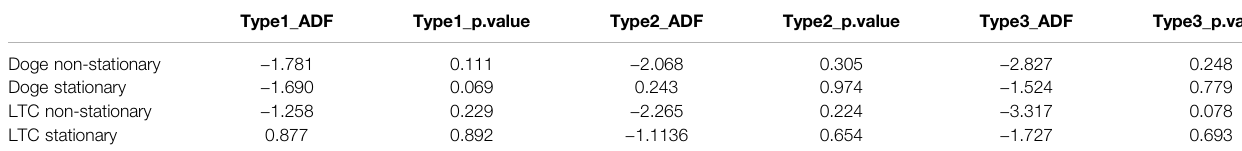
TABLE 1 | Augmented Dickey – Fuller test results for the three types of linear regression models.